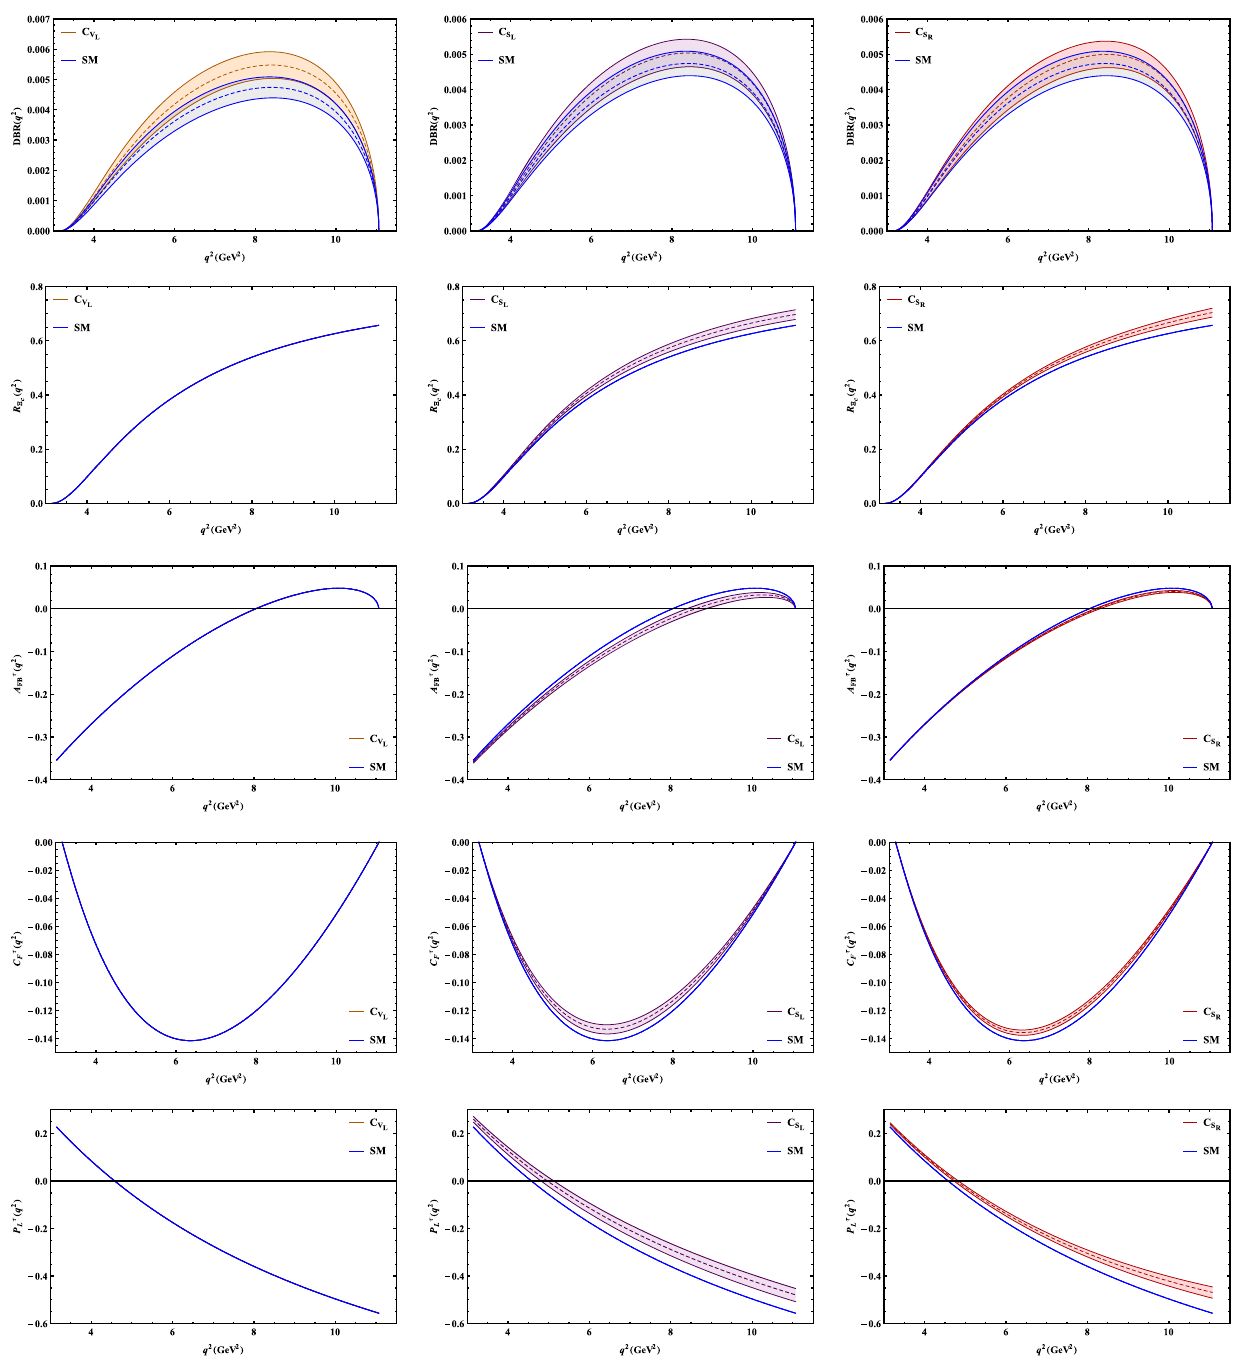
, C ) and scalar ( C S S R ) NP L L decay rate d Γ/ dq 2 is enhanced over the whole q 2 region ), purple ( C S ) and red in the presence of both the vector and scalar couplings for L L → Σ τ − ¯ ν τ decays. For Σ → Σ ∗ τ − ¯ ν τ decay mode, Σ b c b c d Γ/ dq 2 is enhanced with respect to the vector coupling but coupling is largely unaffected by the scalar couplings. In the case L